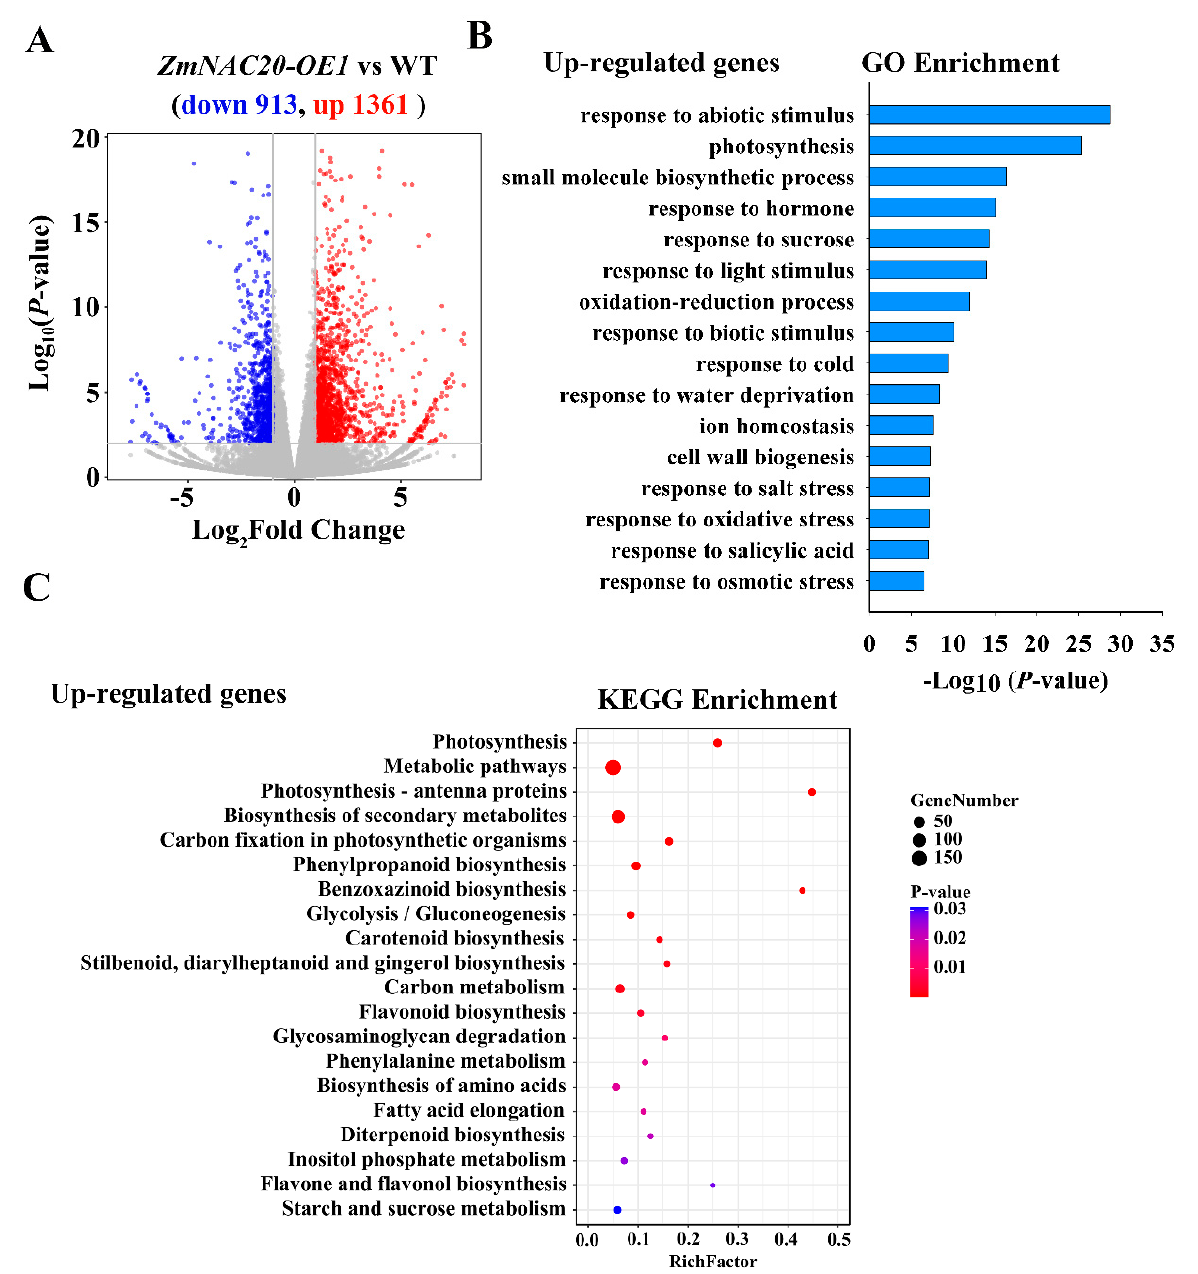
Figure 5. ZmNAC20 regulates multiple signaling under drought stress by RNA-seq analyses. ( A ) Differential gene expression detected by DESeq2. A twofold change in gene expression levels between ZmNAC20-OE1 and wild-type B104 (WT) with a q-value (adjusted p -value) cutoff of 0.05 was considered as a differential expression. A total of 1361 genes were upregulated and 913 genes were downregulated in ZmNAC20-OE1 . ( B ) GO analyses of upregulated genes in ZmNAC20-OE1 . ( C ) KEGG analyses of upregulated genes in ZmNAC20-OE1 .